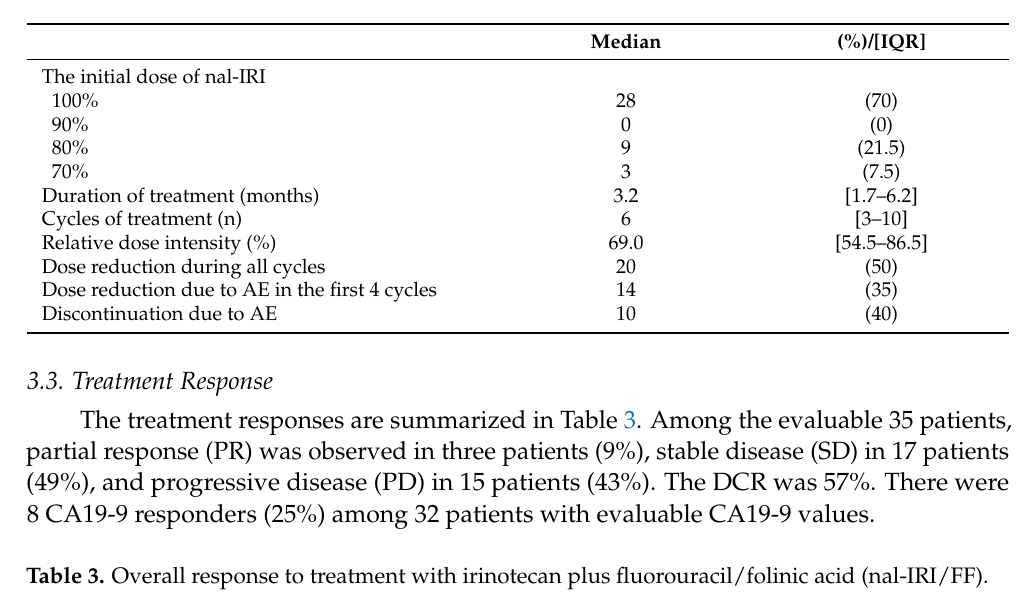
Table 2. Administered dose and attributed reasons for dose reduction or discontinuation.